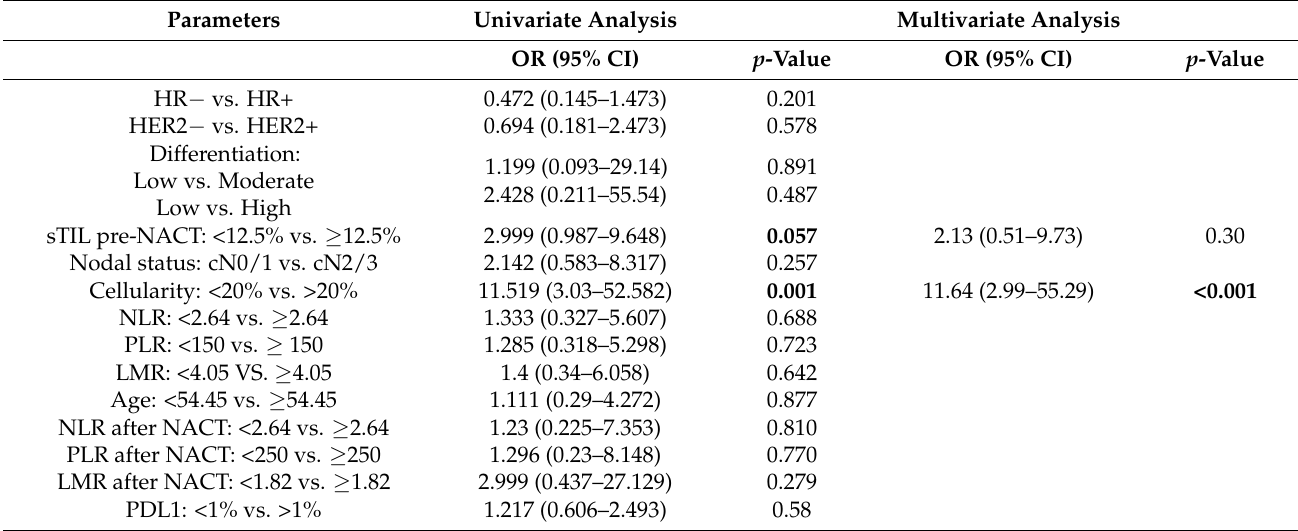
Table 5. Uni- and multivariate analysis: Clinicopathological parameters associated with a higher number of sTIL after NACT in the IBC cohort. IBC: inflammatory breast cancer, HR: hormone receptor status, sTIL: stromal tumour infiltrating lymphocytes, NACT: neo-adjuvant chemotherapy. RD: residual disease, NLR: neutrophil-lymphocyte ratio, PLR: platelet- lymphocyte ratio and LMR: lymphocyte-monocyte ratio. Bold values denote statistical significance at the p < 0.05 level.